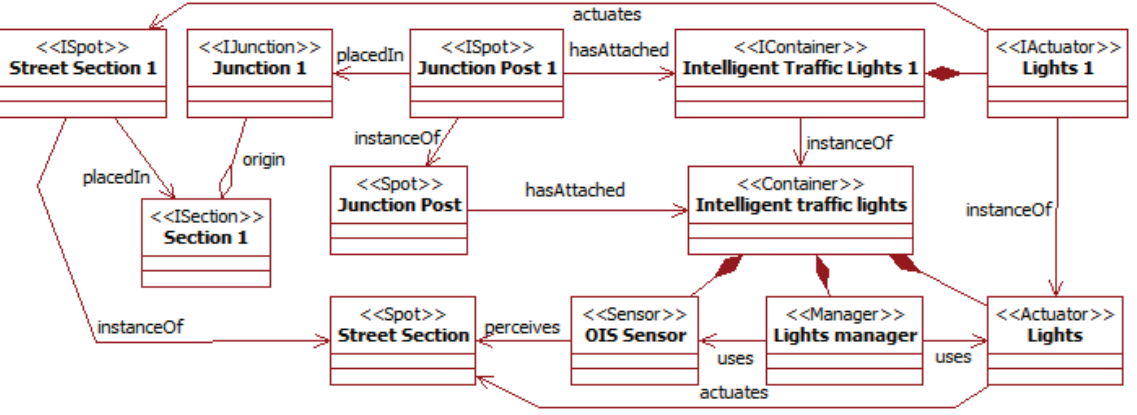
Figure 8. Intelligent traffic lights. Container related